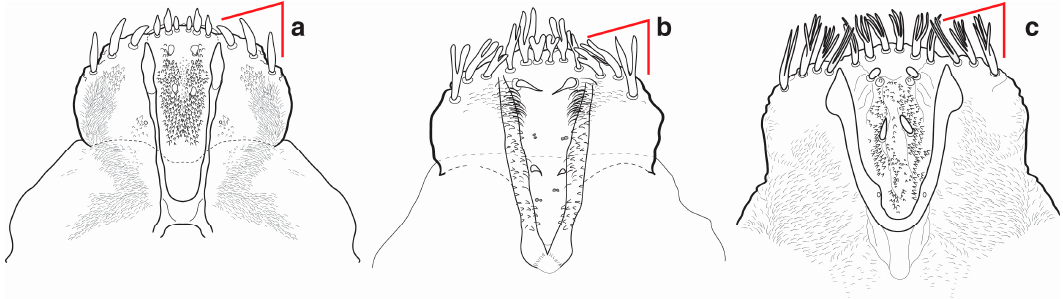
Figure 26. Epipharynx, larva: ( a ) Cactophagus ; ( b ) Eucalandra ; and ( c ) Sipalnus .